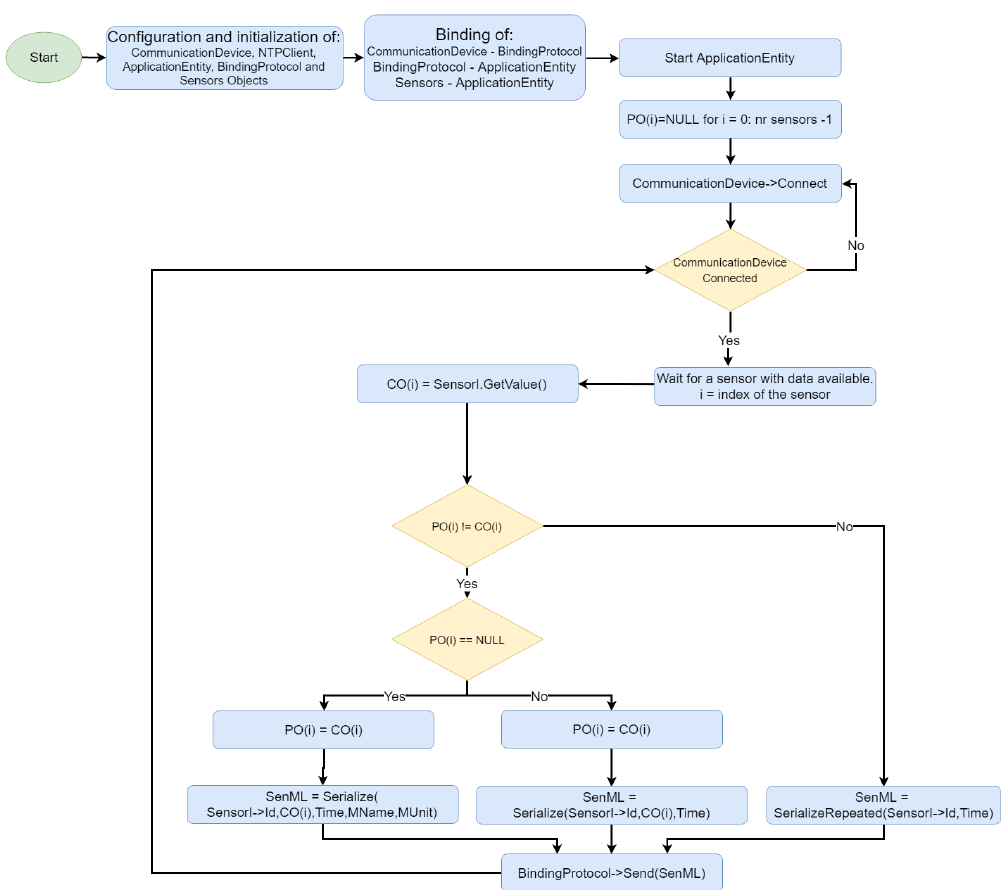
Figure 7. Initialization and message handling on IoMT devices using the development